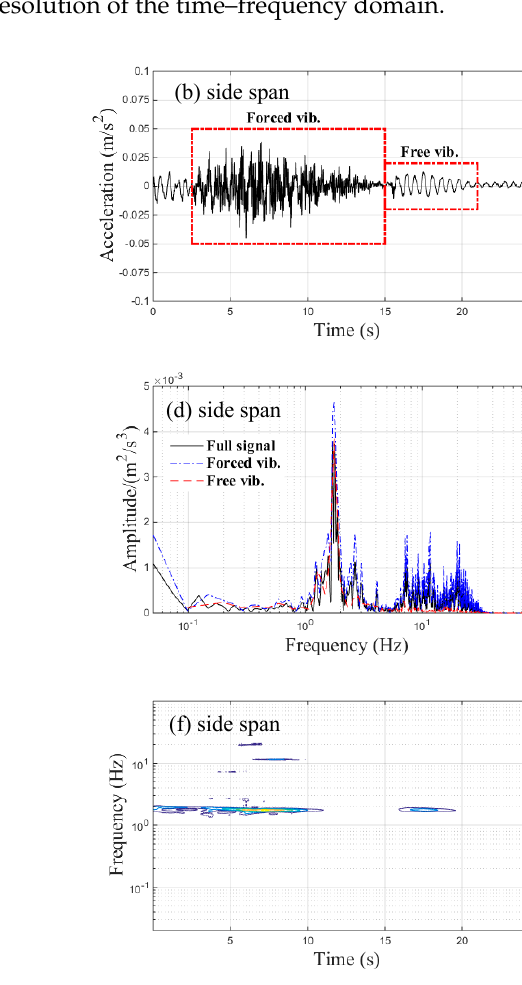
Figure 7. Transverse acceleration signals of the bridge during braking: ( a ) time-history data of the main span; ( b ) time-history data of the side span; ( c ) FFT results of the main span; ( d ) FFT results of the side span; ( e ) TFRs of the main span; ( f ) TFRs of the side span.